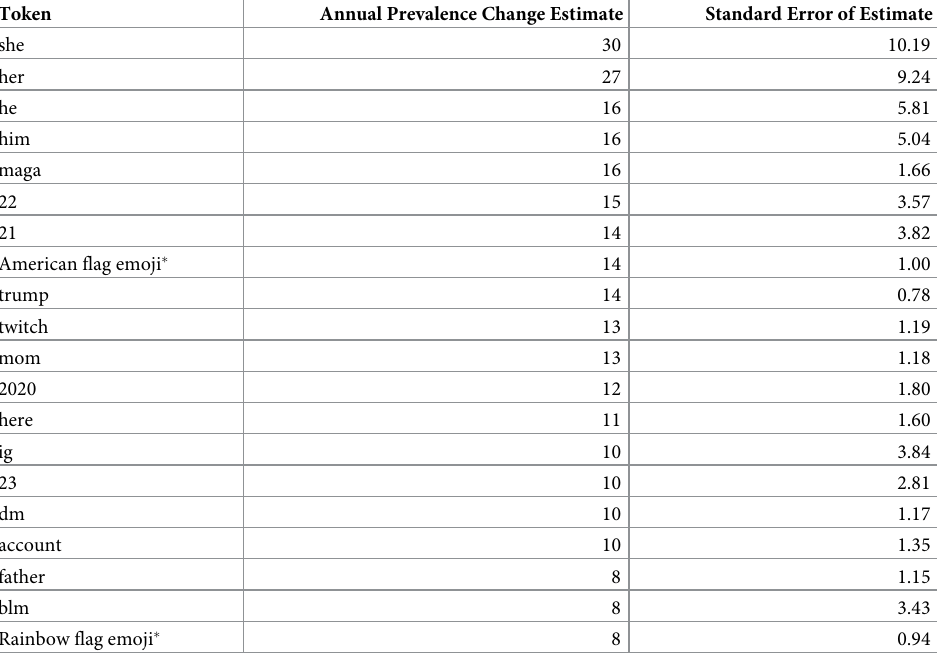
Table 6. Top 20 winner tokens in the cross-sectional sample. Token Annual Prevalence Change